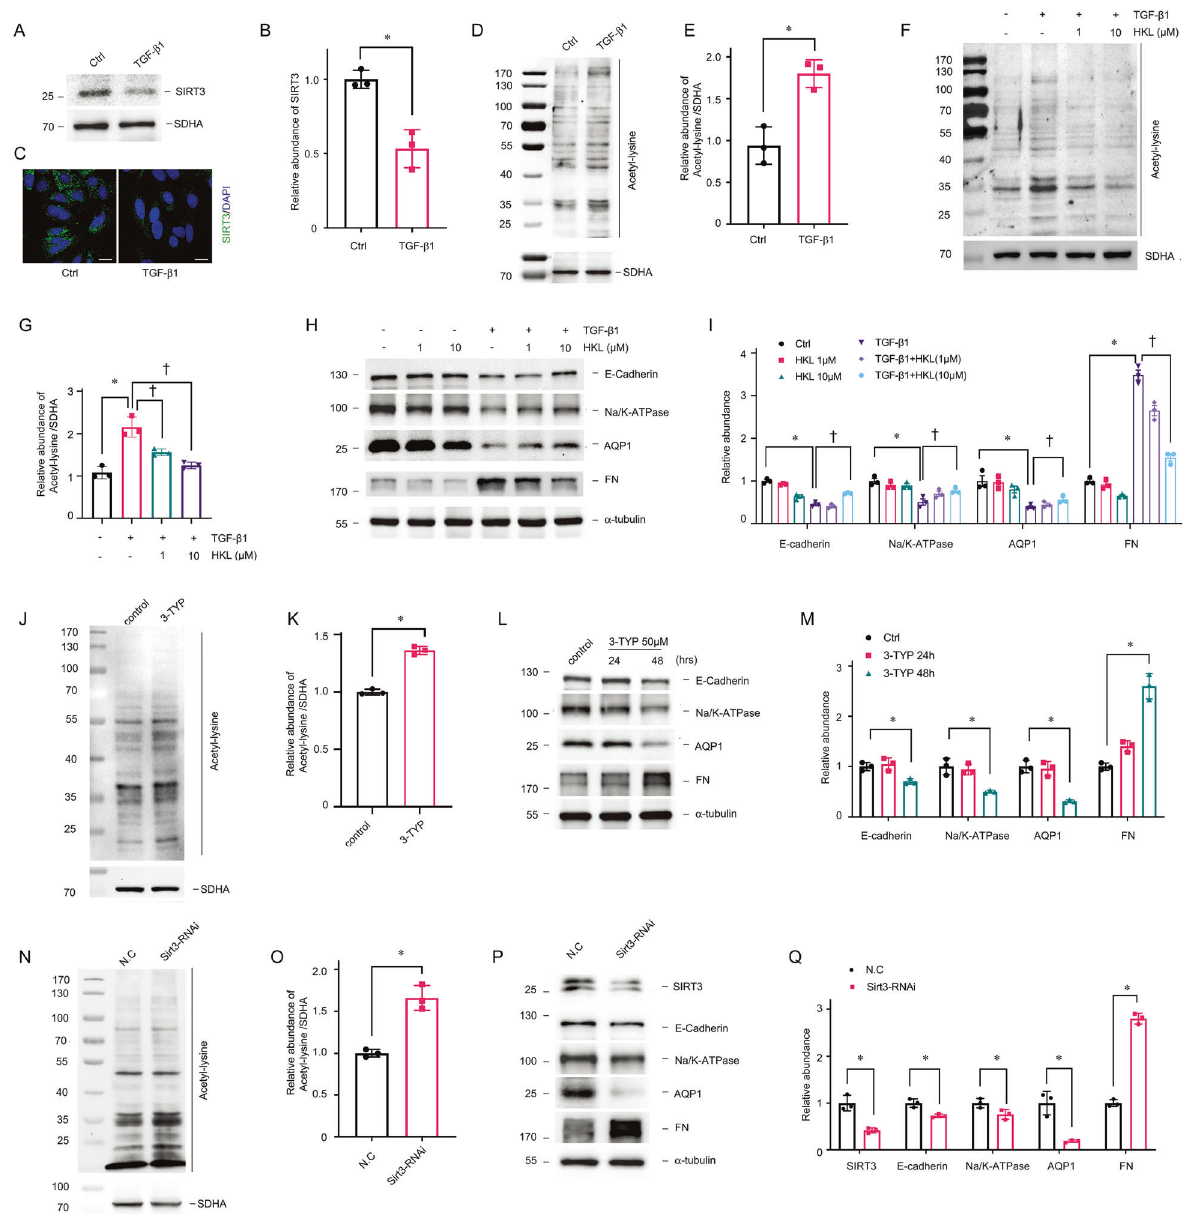
Fig. 4 SIRT3 regulates TGF- β 1 induced mitochondrial hyper-acetylation in TECs. Primary TECs were incubated with TGF- β 1 (5 ng/mL). A , B Western blots of SIRT3 expression after incubation with TGF- β 1 for 1 h. α -tubulin served as the standard (* P < 0.05; n = 3). C Representative fi ndings of immuno fl uorescent staining for SIRT3 in TECs incubated with TGF- β 1. The bar indicates 20 μ m. D , E Acetylation in mitochondrial lysates from TECs incubated with TGF- β 1 for 1 h. SDHA served as the standard (* P < 0.05; n = 3). F , G Western blots of acetylated lysine in mitochondrial lysates from TECs incubated with HKL then TGF- β 1 stimulation for 1 h. SDHA served as the standard (* P < 0.05, † P < 0.05; n = 3). H , I Western blots of E-cadherin, Na/K-ATPase, AQP1, and FN in TECs incubated with HKL then stimulated with TGF- β 1 for 48 h. α -tubulin served as the standard (* P < 0.05, † P < 0.05; n = 3). J , K Western blots of acetylated-lysine in mitochondrial lysates from TECs incubated for 15 min with SIRT3 selective inhibitor, 3-TYP (50 μ M). SDHA served as the standard (* P < 0.05; n = 3). L , M Western blots of E-cadherin, Na/K- ATPase, AQP1, and FN in TECs incubated with 3-TYP (50 μ M) for 24 and 48 h. α -tubulin served as the standard (* P < 0.05, † P < 0.05; n = 3). N , O Western blots of acetylated lysine in mitochondrial lysates from TECs transfected with Sirt3 siRNA compared with negative control (NC). SDHA served as the standard (* P < 0.05; n = 3). P , Q Western blots of SIRT3, E-cadherin, Na/K-ATPase, AQP1, and FN in TECs transfected with NC and Sirt3 siRNA. α -tubulin served as the standard (* P < 0.05; n =